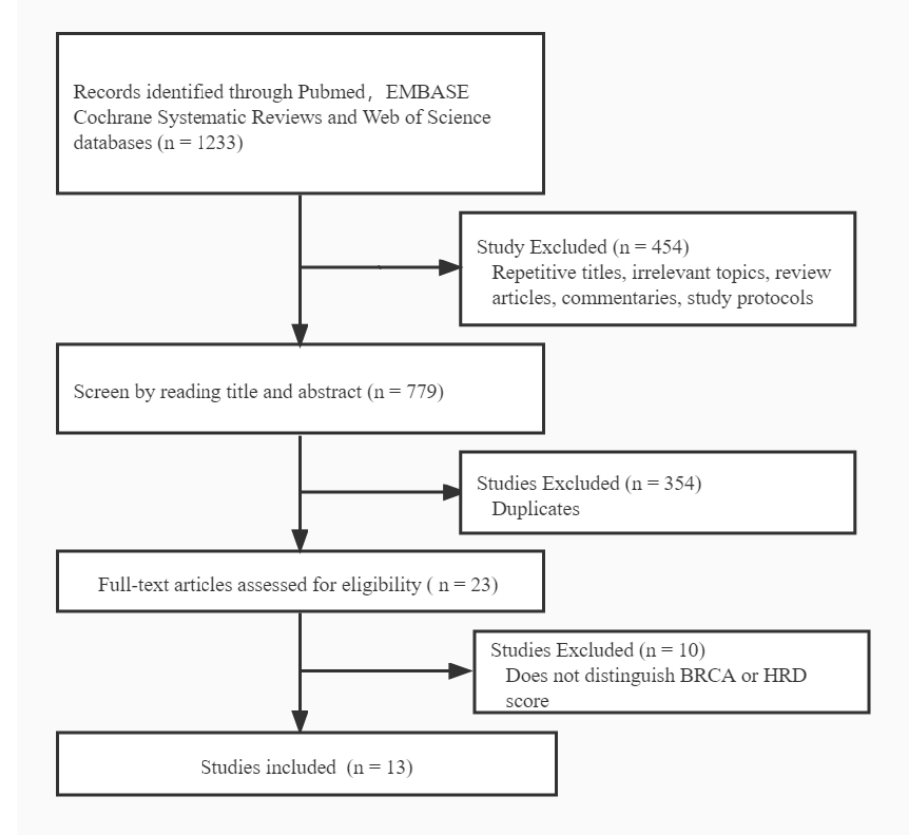
Figure 2. Flowchart of the literature search. Table 1. Characteristics of the included studies.